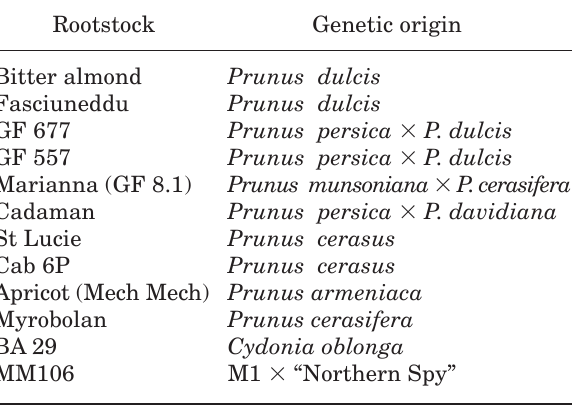
Table 1. Rootstocks used in the study.